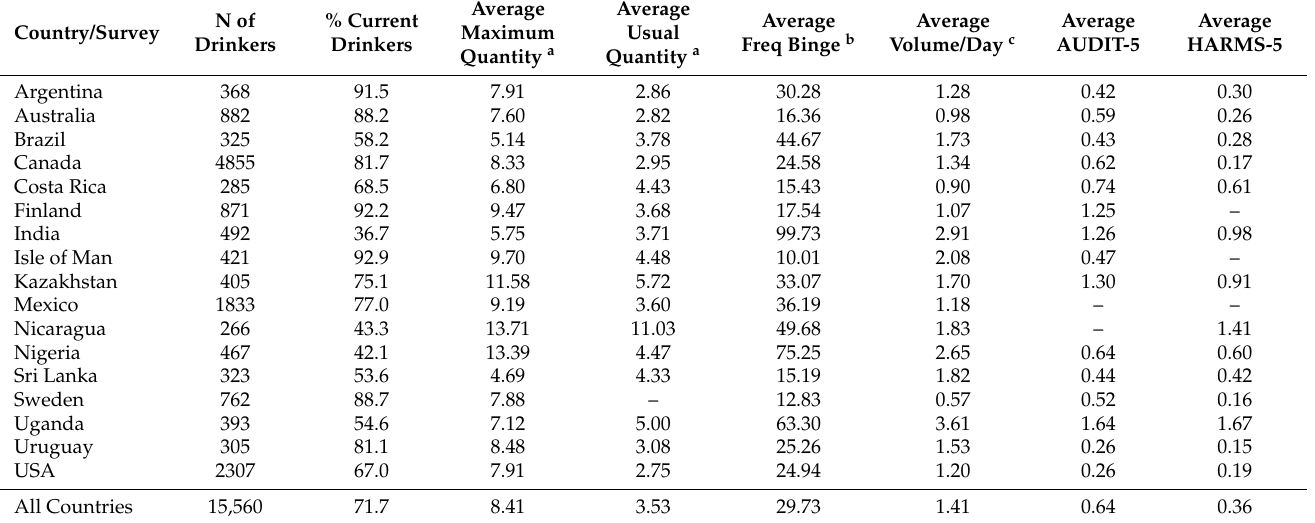
Table 2. Male Drinking and Problem